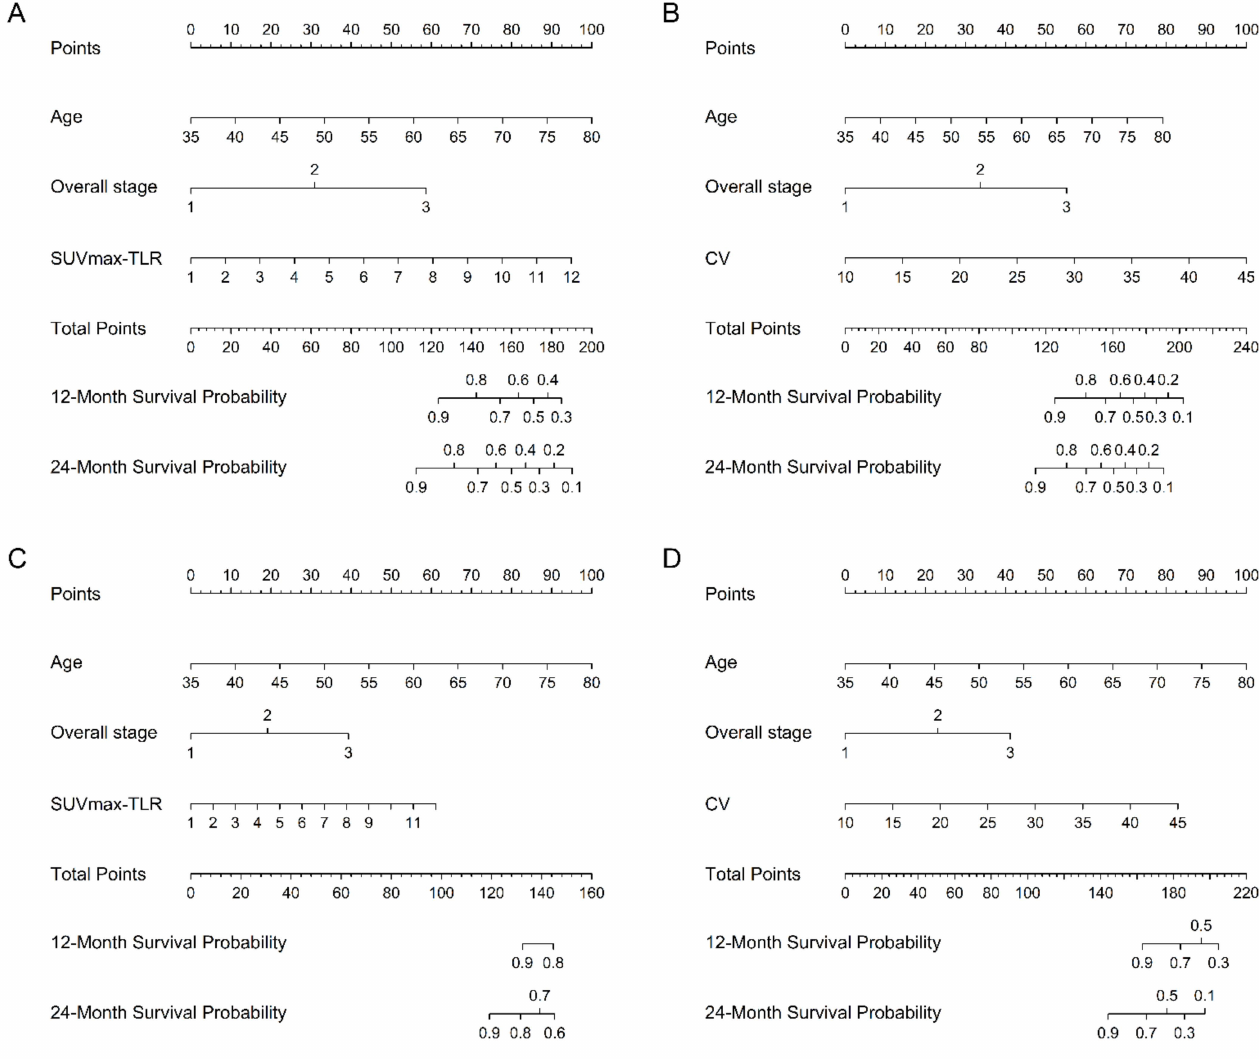
Figure 4. Nomograms predicting the 1- and 2-year progression-free ( A , B ) and overall ( C , D ) survival rates. To calculate predicted survival, a straight line is drawn up to the row labeled “Points” to determine the corresponding points for each factor. The total points projected on the bottom scales show the probabilities of 1- and 2-year progression-free survival or overall survival. SUV max -TLR, tumor SUV max to liver SUV mean ratio; CV, coefficient of